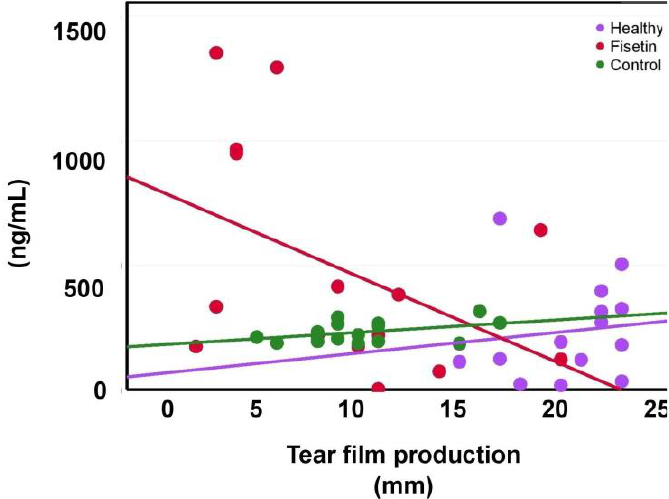
Figure 5. Scatter plot showing the relationship between matrix metalloproteinase 9 (MMP-9) in healthy (purple), fisetin (red), and control (green) groups and tear production. Statistical significance was tested using Pearson’s correlation .